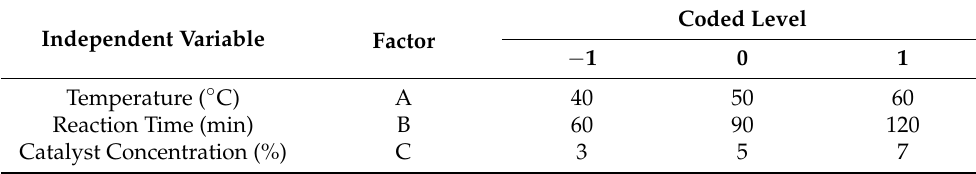
Table 1. Independent Variables Range and Level Used in BBD Experimental